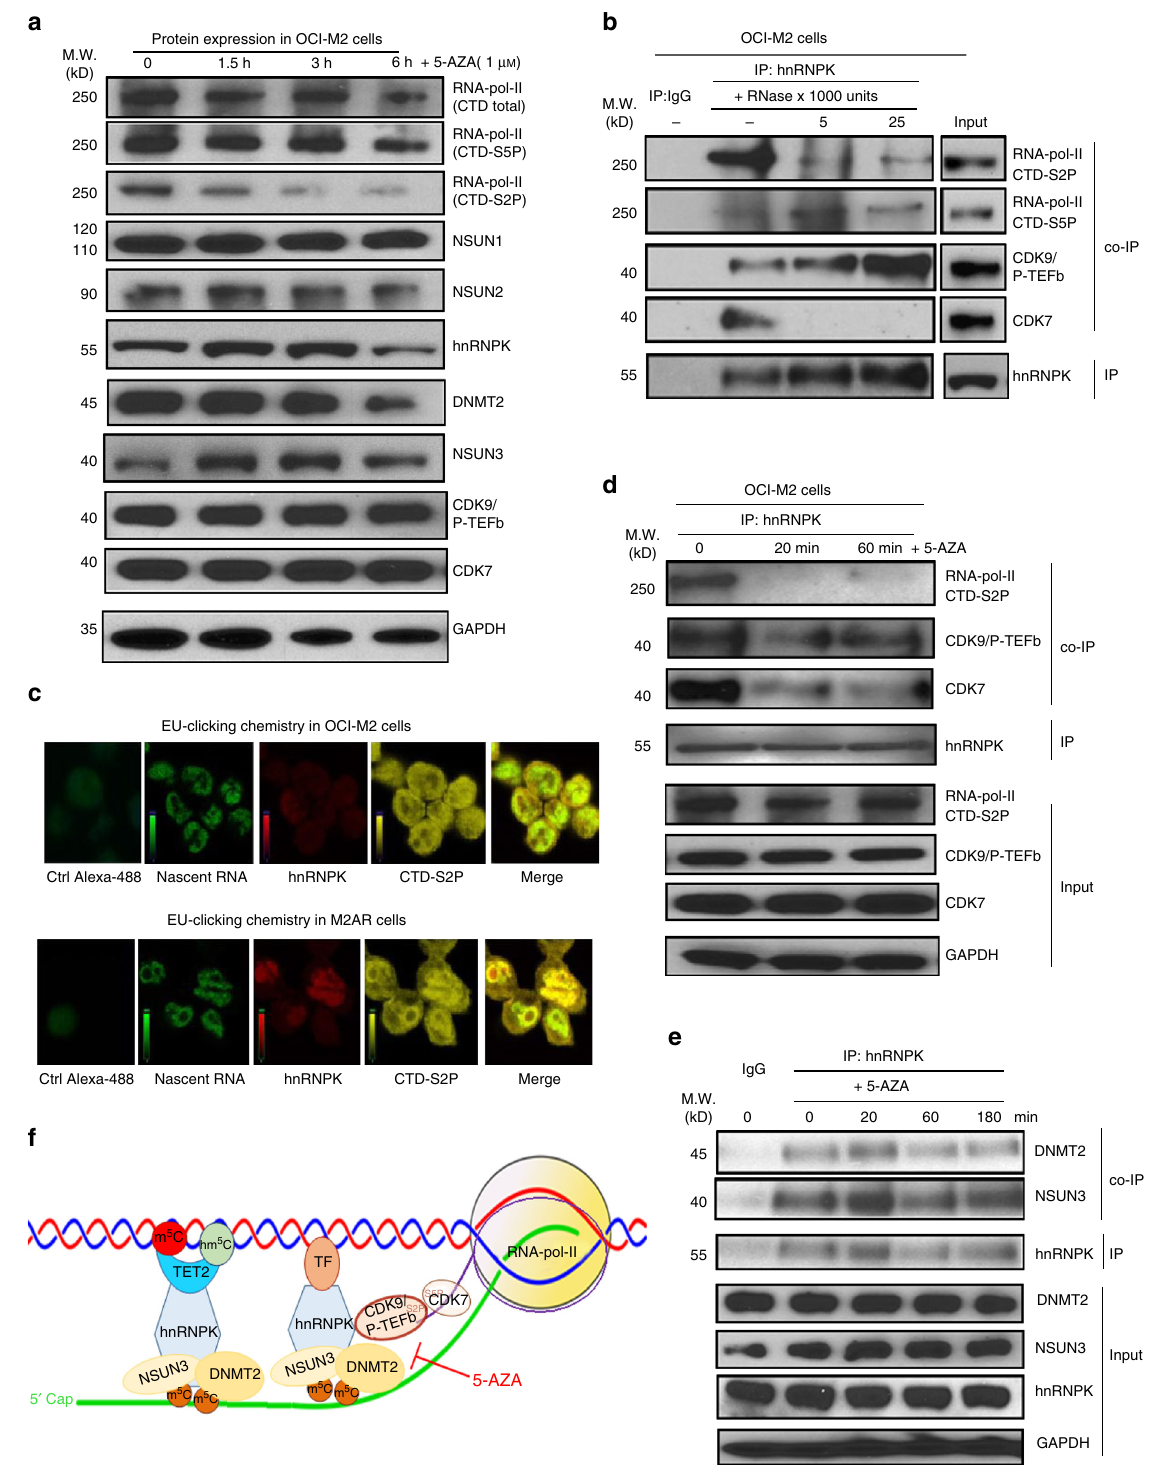
Fig. 5 5-AZA disrupts the interaction between active RNA-pol-II complex and hnRNPK/RCMT complex. a Examination of the effects of various epigenetic drugs on the growth of OCI-M2 and SC leukaemia cells. b Examination of the interactions between hnRNPK and the components of active RNA-pol-II complex and their RNA-dependence by RNase digestion-coupled co-IPs in OCI-M2 cells. c Elucidation of the subcellular localization and co-localization of hnRNPK with active RNA-pol-II CTD-S2P at nascent RNA in OCI-M2 cells by 5-ethynyluridine (EU) clicking chemistry STED confocal microscopy in OCI- M2 and M2AR cells. d Examination of the effects of 5-AZA on the interactions between hnRNPK and the components of active RNA-pol-II complex, including RNA-pol-II CTD-S2P, RNA-pol-II S5P, CDK7 and CDK9/P-TEFb in OCI-M2 cells treated with 1 μ M 5-AZA for various times. e Examination of the effects of 5-AZA on the interactions between hnRNPK and DNMT2 as well as NSUN3 by co-IPs in OCI-M2 cells treated with 1 μ M 5-AZA for various times. f A schematic presentation of the hnRNPK/RCMT-associated, 5-AZA-sensitive, active chromatin structure at nascent RNA in 5-AZA-sensitive leukaemia